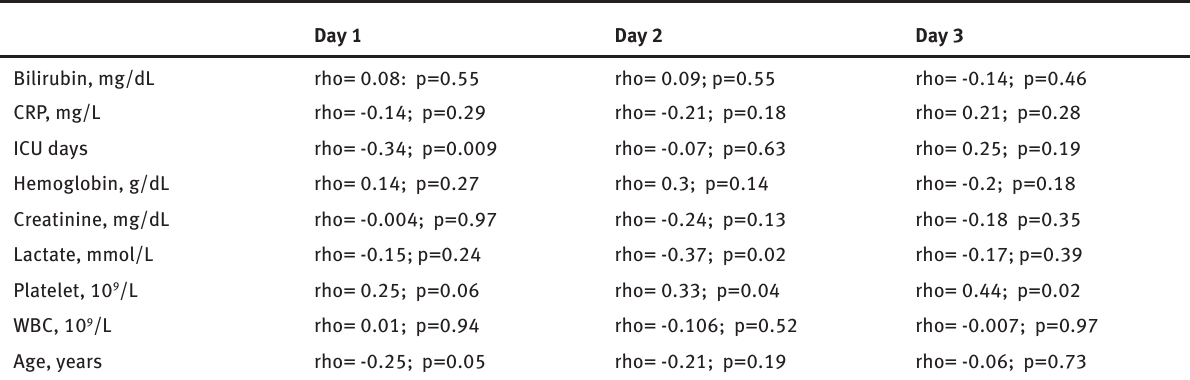
Table 3: Correlation between MMP-9/TIMP-1 ratio levels and bilirubin, CRP, hemoglobin, creatinine, lactate, platelet and ICU length of stay on days 1, 2 and